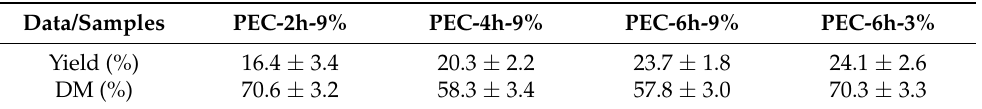
Table 2. Percentage of yield and degree of methoxylation (DM) of pectin as a function of time (h) and acetic acid concentration (%).